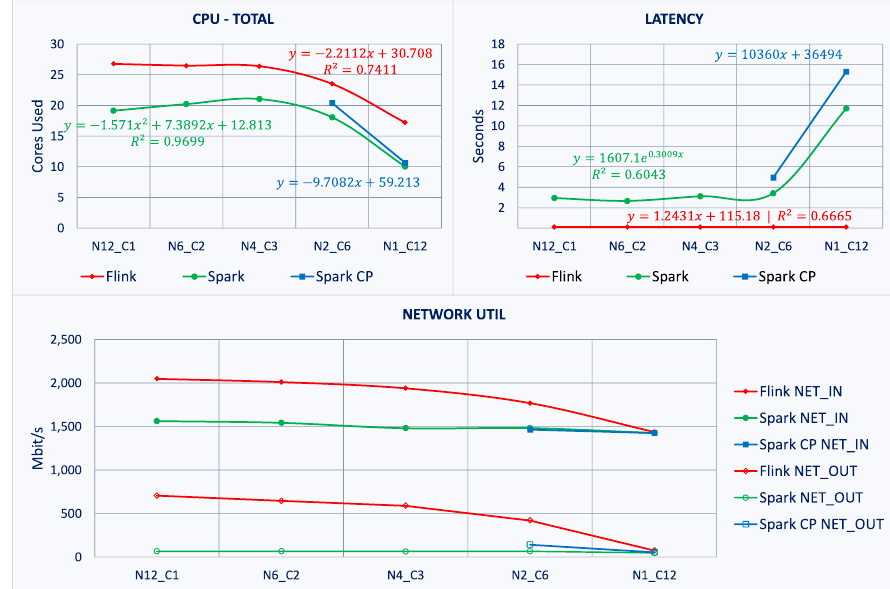
Figure 13. CPU consumption per task for different cluster configurations’